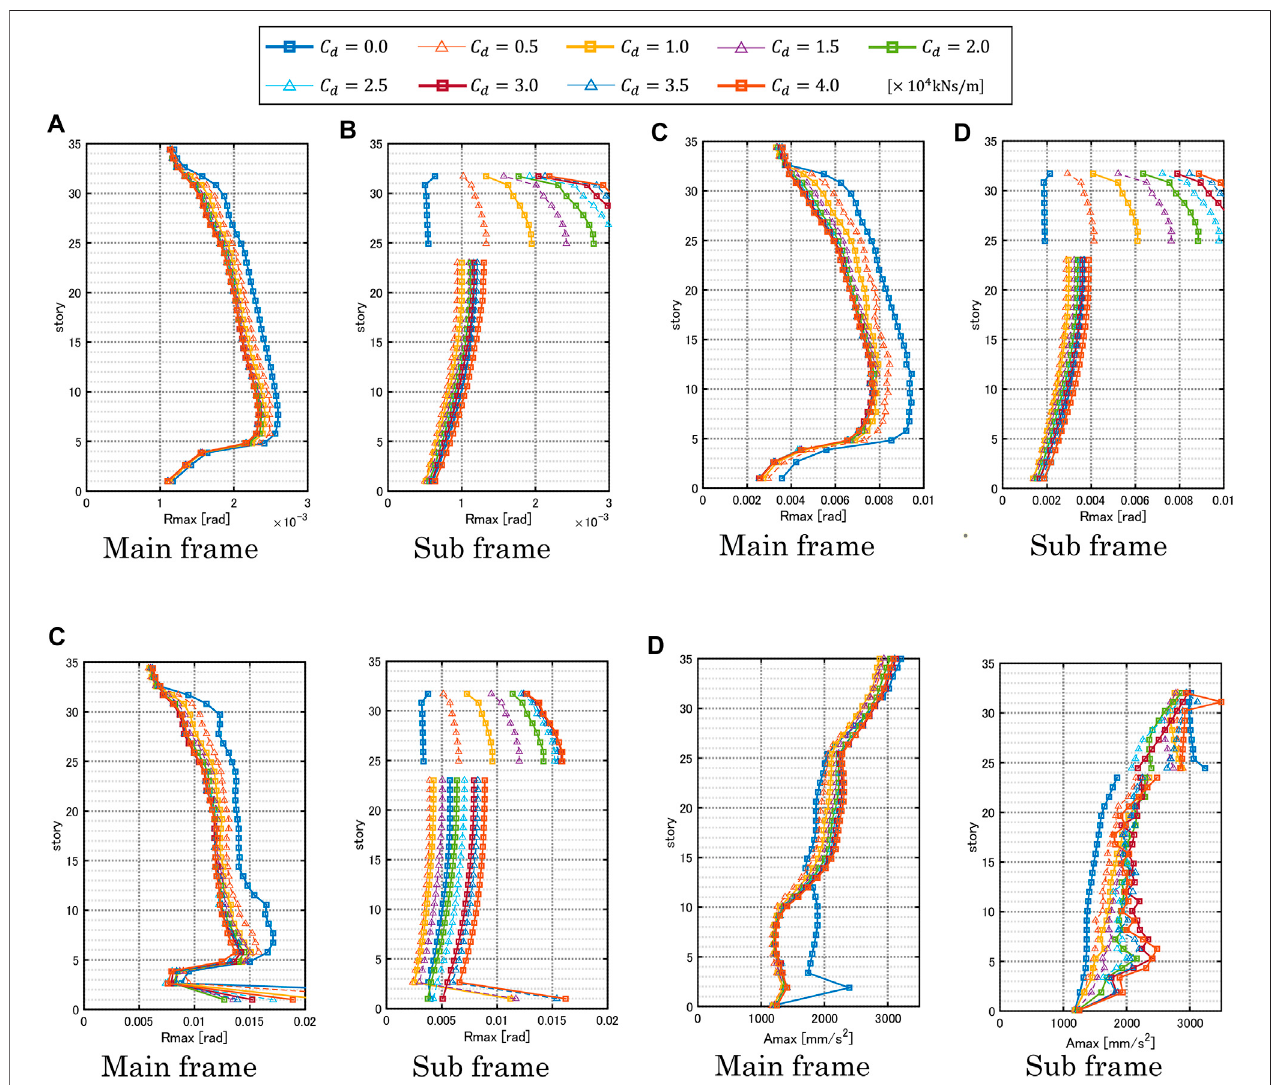
FIGURE 10 | Maximum interstory drift angle under critical double impulse and maximum acceleration under equivalent one-cycle sinusoidal wave for various damper quantities, (A) Maximum interstory drift angle for V DI (cid:1) 0 . 20 [ m / s ] , (B) Maximum interstorydrift angle for V DI (cid:1) 0 . 60 [ m / s ] , (C) Maximum interstory drift angle for V DI (cid:1) 1 . 00 [ m / s ] , (D) Maximum acceleration for one-cycle sinusoidal wave equivalent to V DI (cid:1) 1 . 00 [ m / s ] .